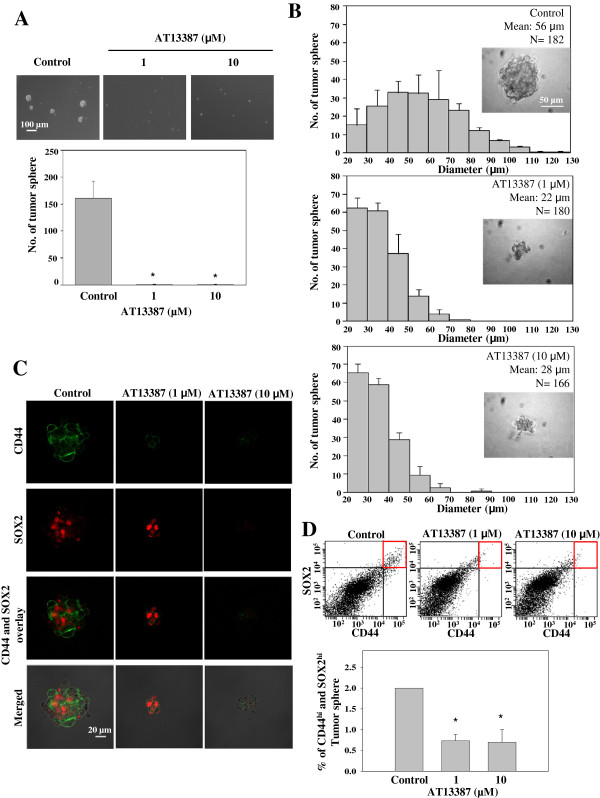
Effect of AT13387 on C666-1 tumor sphere. (A) AT13387 was added on day 0 of C666-1 tumor sphere formation. Upper panel: image of tumor spheres formed from C666-1 single cell culture with and without AT13387 treatment. AT13387 significantly inhibited tumor sphere formation. Scale bar = 100 μm. Lower panel: Total number of tumor spheres per culture. Tumor spheres formed with diameter reaching 20 μm were counted. Results were expressed as the mean ± S.D. of three experiments; *p < 0.05. (B) Size profile of C666-1 tumor spheres. AT13387 was added to the tumor sphere culture after tumor spheres were formed for 7 days. The diameters of tumor spheres were measured after AT13387 treatment for 7 more days and presented as the size profile of tumor sphere. The mean diameters of tumor spheres with AT13387 treatment were significantly smaller than the untreated control (p < 0.05), showing the inhibitory effect of AT13387 on the growth of C666-1 tumor sphere. Scale bar = 50 μm. Results were expressed as the mean ± S.D. of three experiments. (C) Confocal image showing pseudocolor green for CD44 and red for SOX2. Loss of CD44 was observed in 1 μM AT13387-treated C666-1 tumor sphere and loss of both CD44 and SOX2 were observed in 10 μM AT13387-treated C666-1 tumor sphere. Scale bar = 20 μm. (D) FACS analysis showing the decrease of CD44hi and SOX2hi population in AT13387-treated C666-1 tumor sphere. Results were expressed as the mean ± S.D. of three experiments; *p < 0.05.